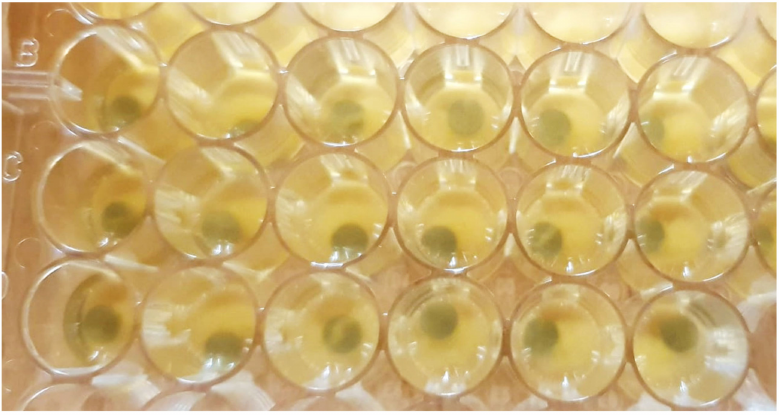
Figure 3. View of titanium discs with biofilm immersed in a suitable nutrient medium (Group C) before the experiments and the microbiological